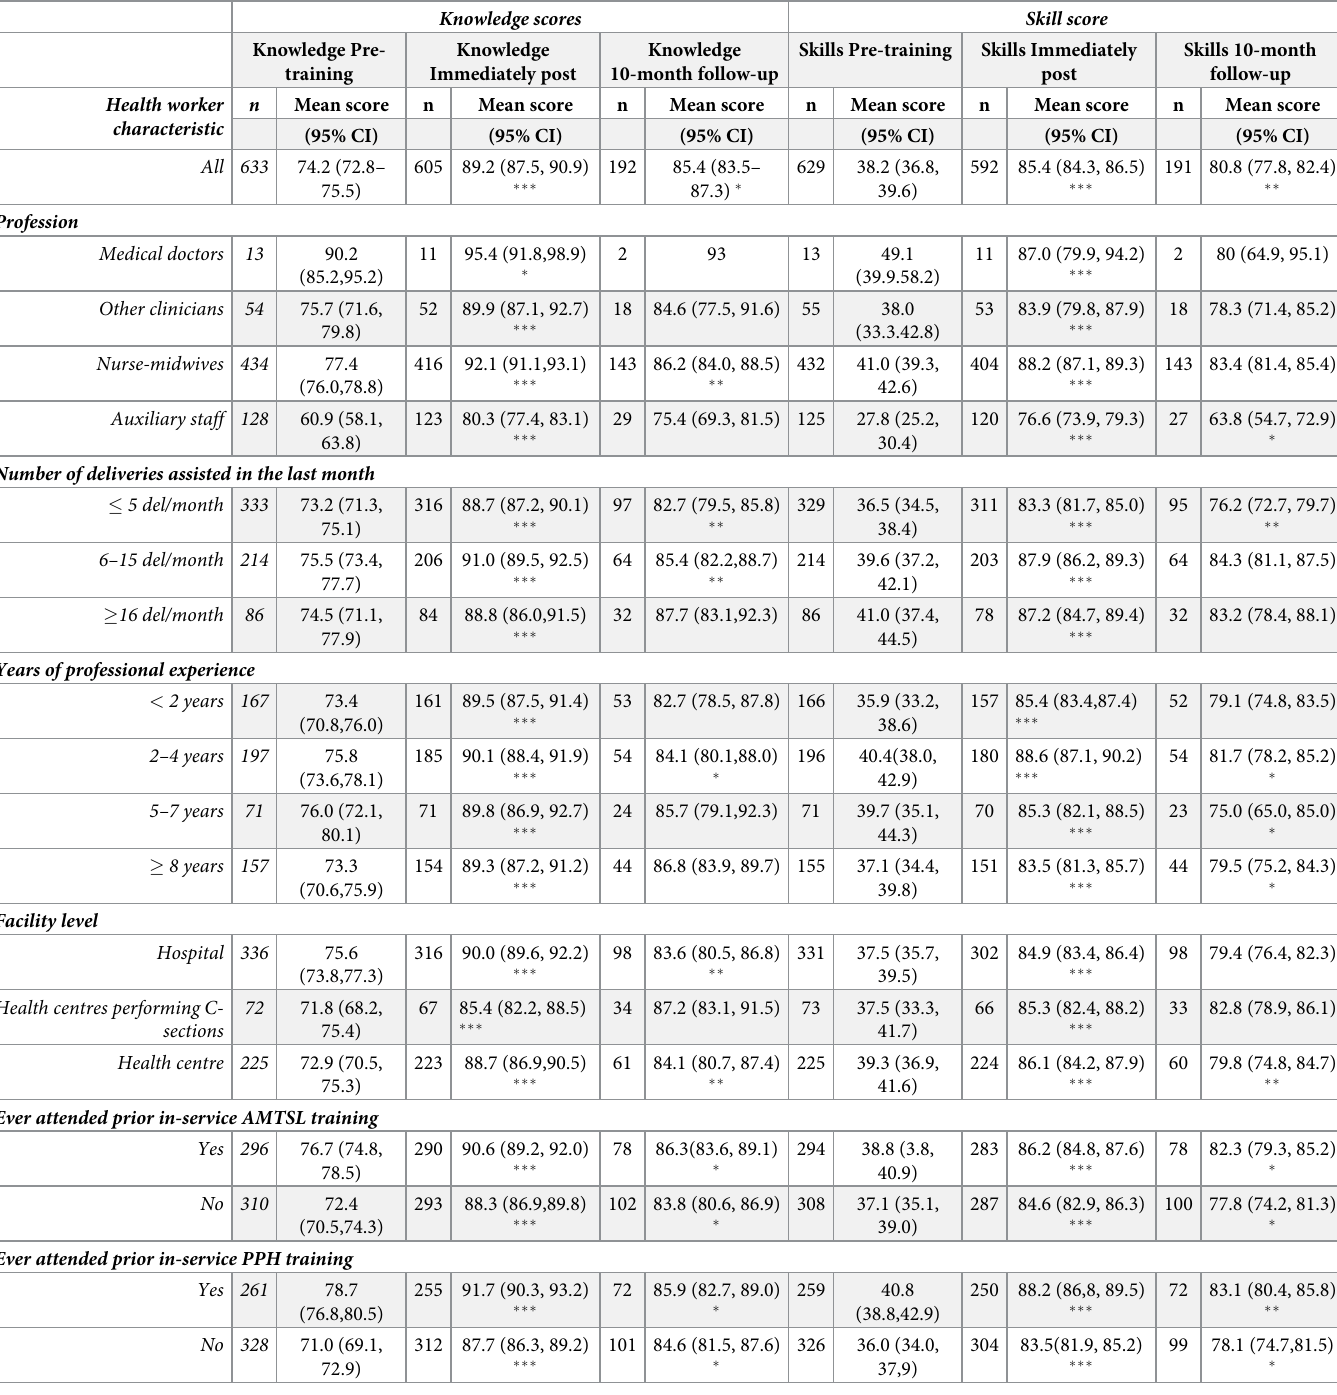
Table 2. Knowledge and skills scores pre-, immediately after and at 10-month follow-up of the HMS BAB training by health worker’s